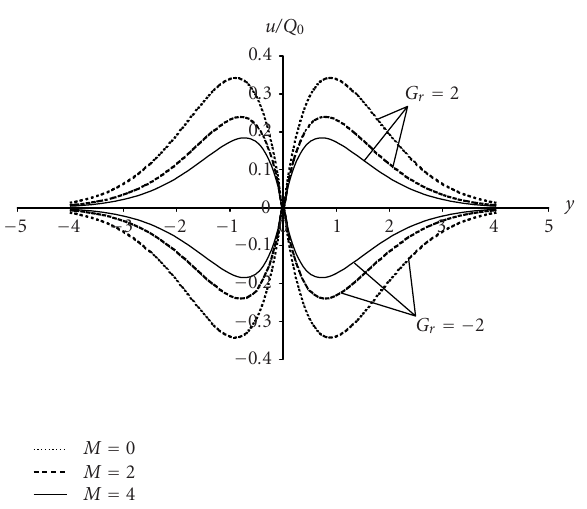
Figure 7.3. The velocity distribution for di ff erent values of M for the whole-space problem.